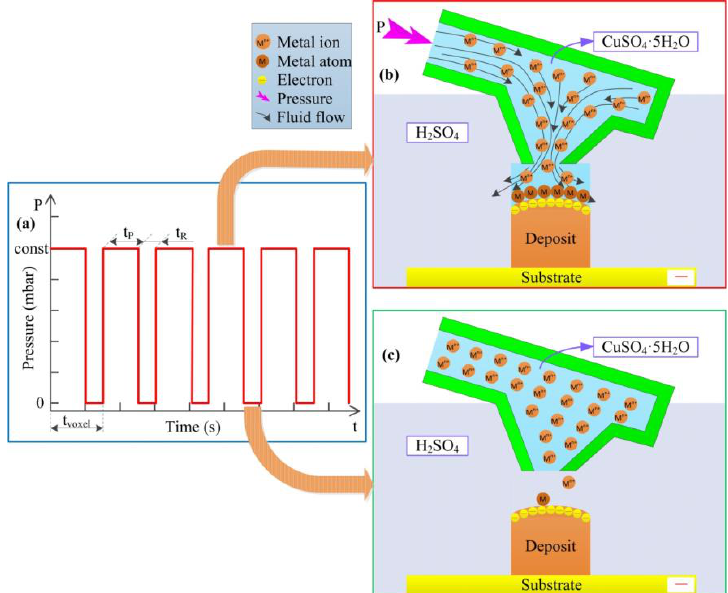
Figure 7. Theoretical diagram of the effect of pulse pressure on the deposition process. ( a ) is a relationship between the pressure and the time in process. ( b ) is the deposition process with pressure. ( c ) is the deposition process without pressure.